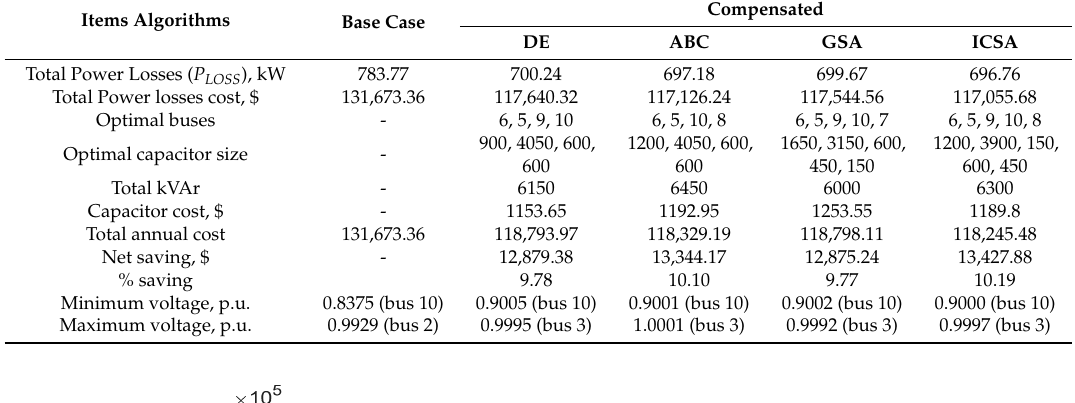
Table 9. Experimental results of 10-bus system.